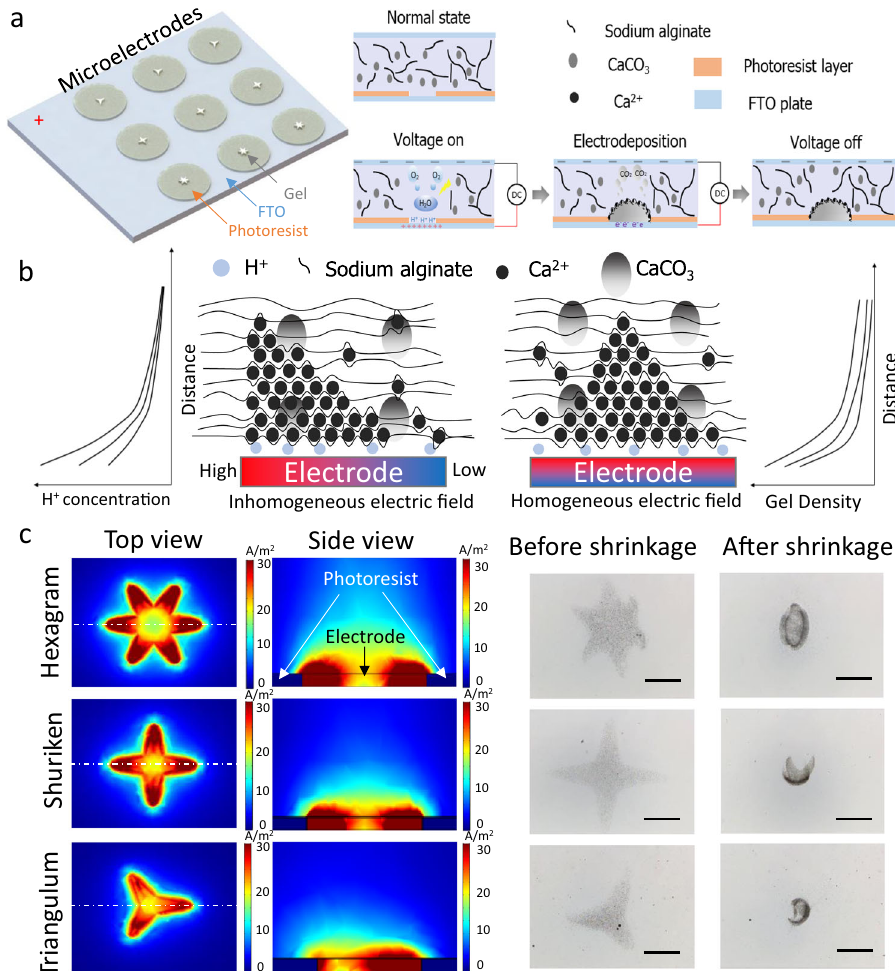
Fig. 2 Principle of programmed shape deformation. a Fabrication of microelectrodes and ISMEs. The various patterned microelectrodes are fabricated by coating a layer of photoresist on the FTO glass and photolithography. And the ISME is fabricated through inhomogeneous electrodeposition. b Schematic of alginate hydrogel electrodeposition under different electric fi elds. Two fi gures represent that the H + concentration and gel always decrease along the perpendicular direction. c Current density simulation and deformation of the corresponding alginate hydrogel hexagram, shuriken, and triangulum ISME microstructures. Through the design of the microelectrodes and the control of current density, the inhomogeneity electric fi eld can be generated. Under inhomogeneous electrodeposition, the alginate microstructures are able to achieve shape morphing under pH or ionic stimulus. Scale bar: 500 μ